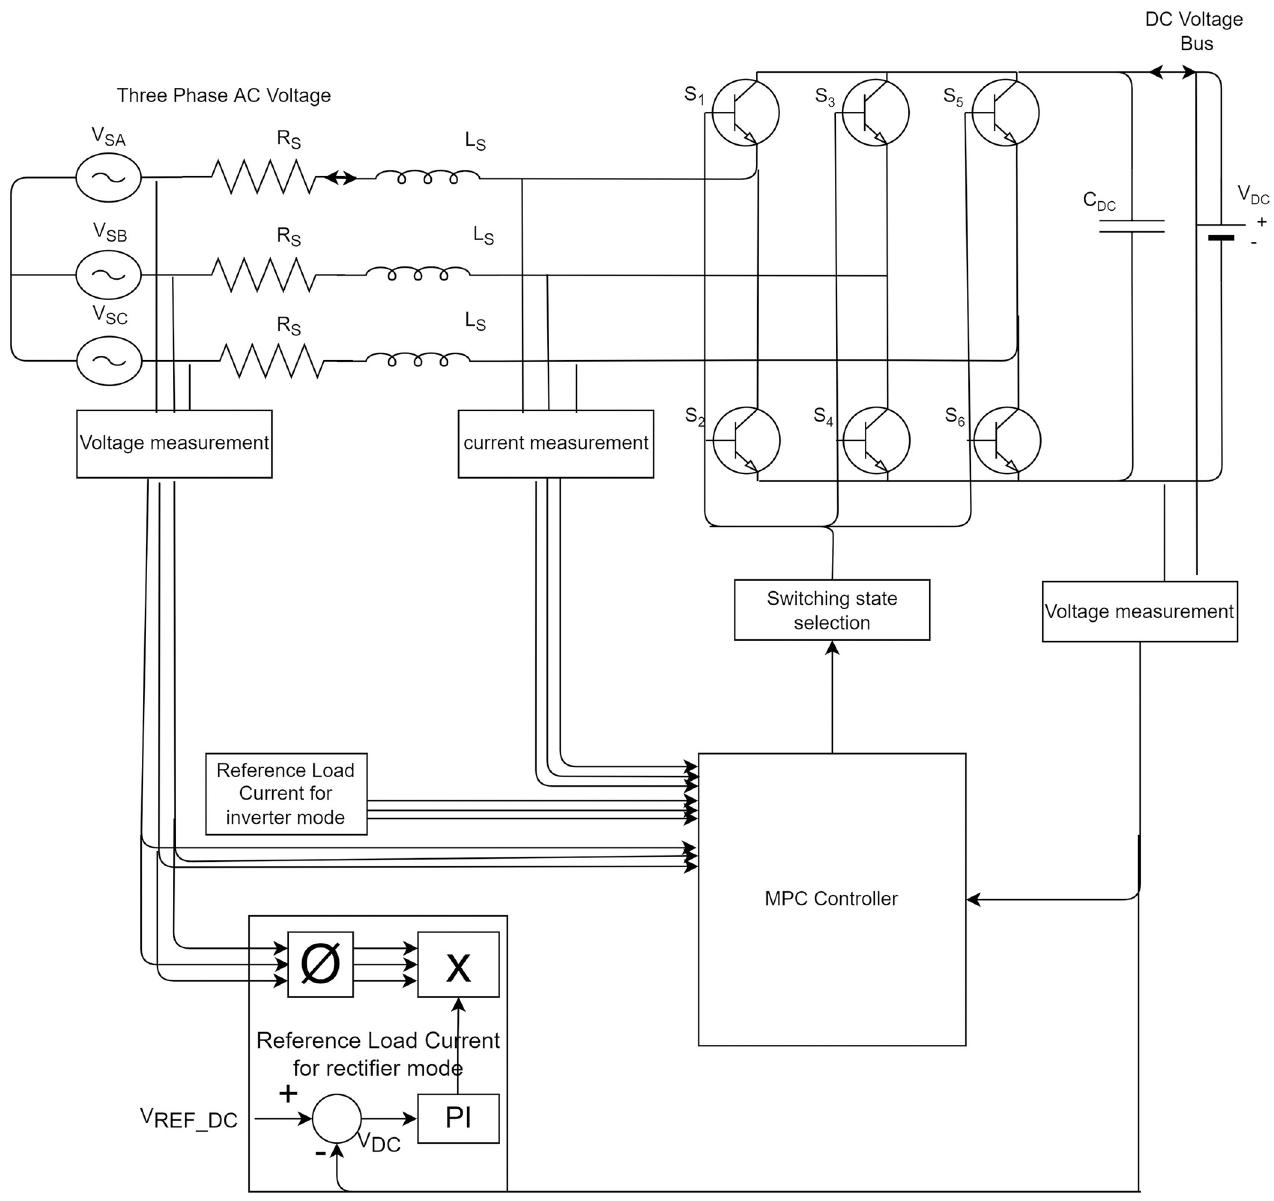
Fig 3. MPC block diagram for GFM and GFE operation through AC/DC